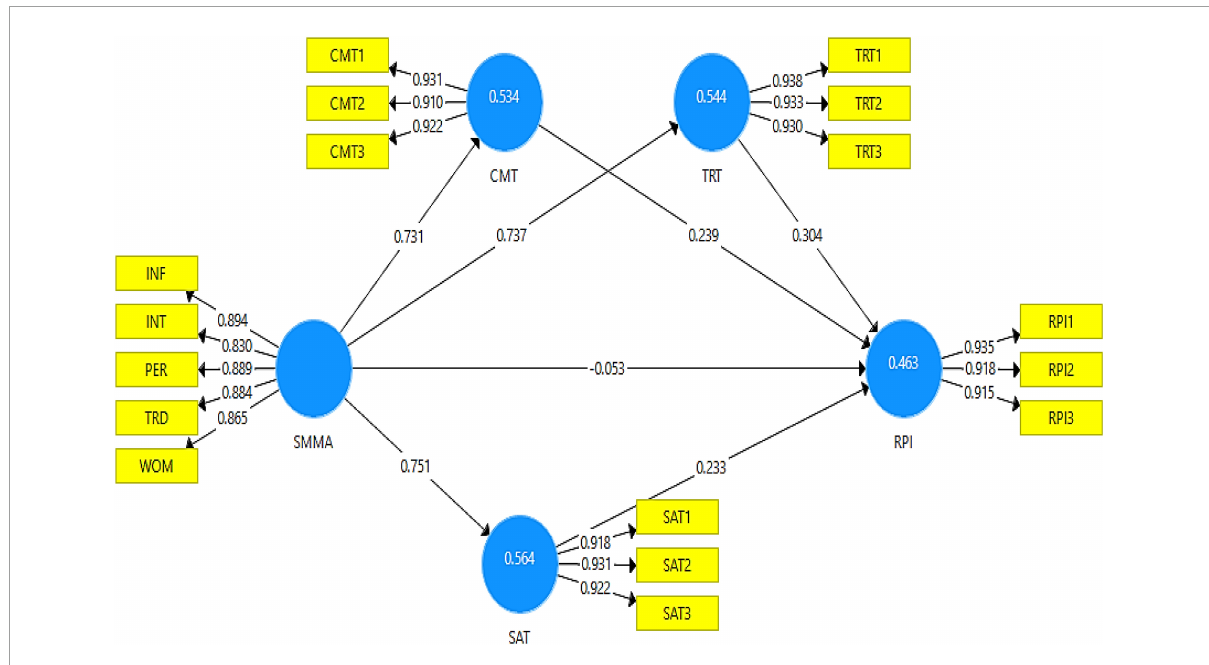
FIGURE3 Proposed model relationships and loading